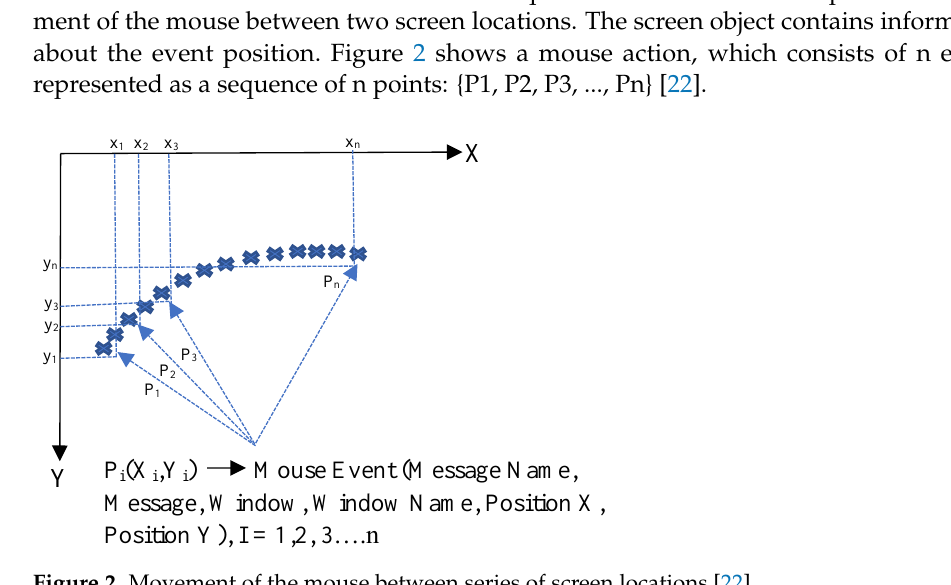
Figure 2. Movement of the mouse between series of screen locations.